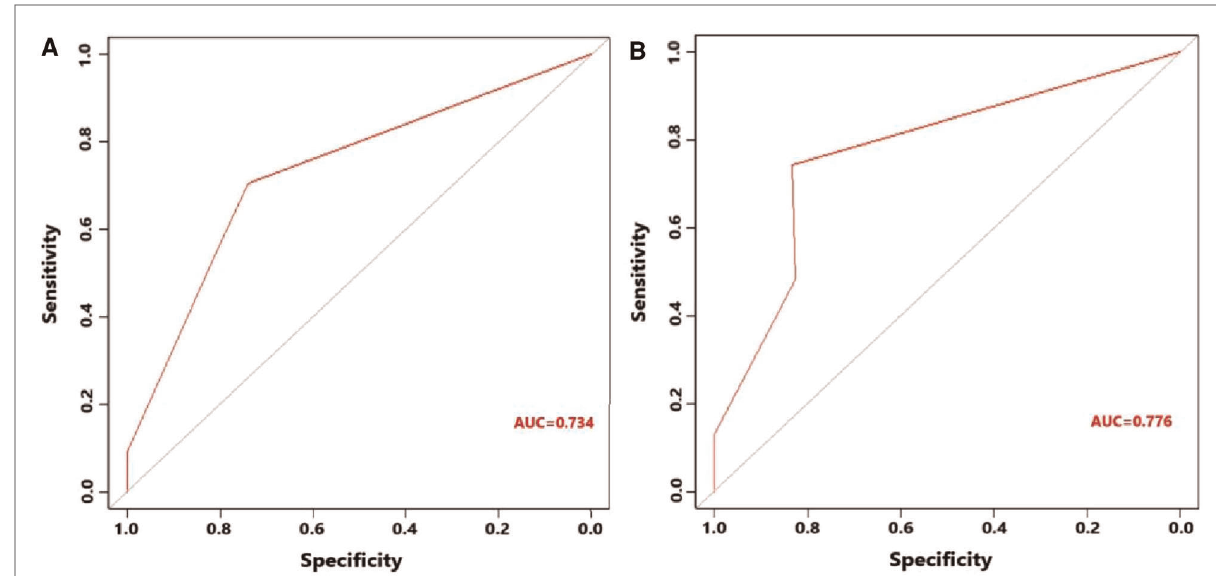
FIGURE 7 ( A ) Receiver operating characteristic curve of the constructed nomogram for predicting 1-year survival of gallbladder cancer patients with liver metastasis in the training cohort. ( B ) Receiver operating characteristic curve of the constructed nomogram for predicting 1-year survival of gallbladder cancer patients with liver metastasis in the testing cohort.